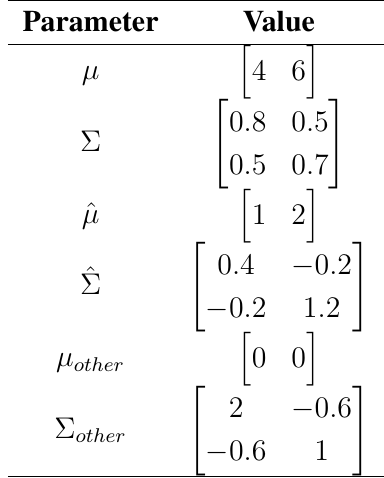
Table 3. Parameters used in the